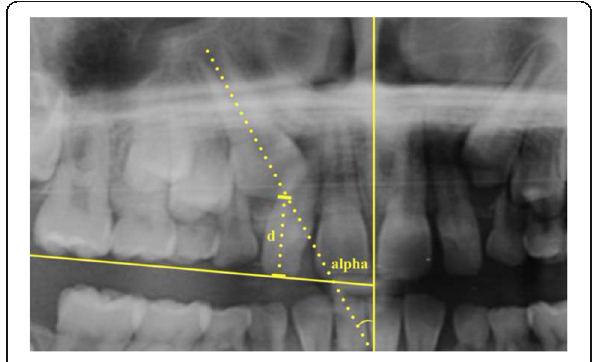
Fig. 2 Diagrammatic representation of the measurement of the angulation and the distance from the occlusal plane [5]